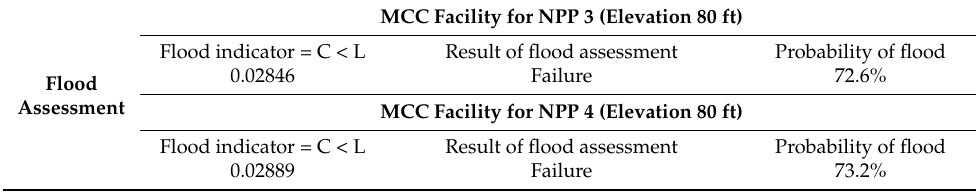
Figure 23. Probabilistic flood assessment result for NPP 4. Table 18. Probabilistic flood assessment